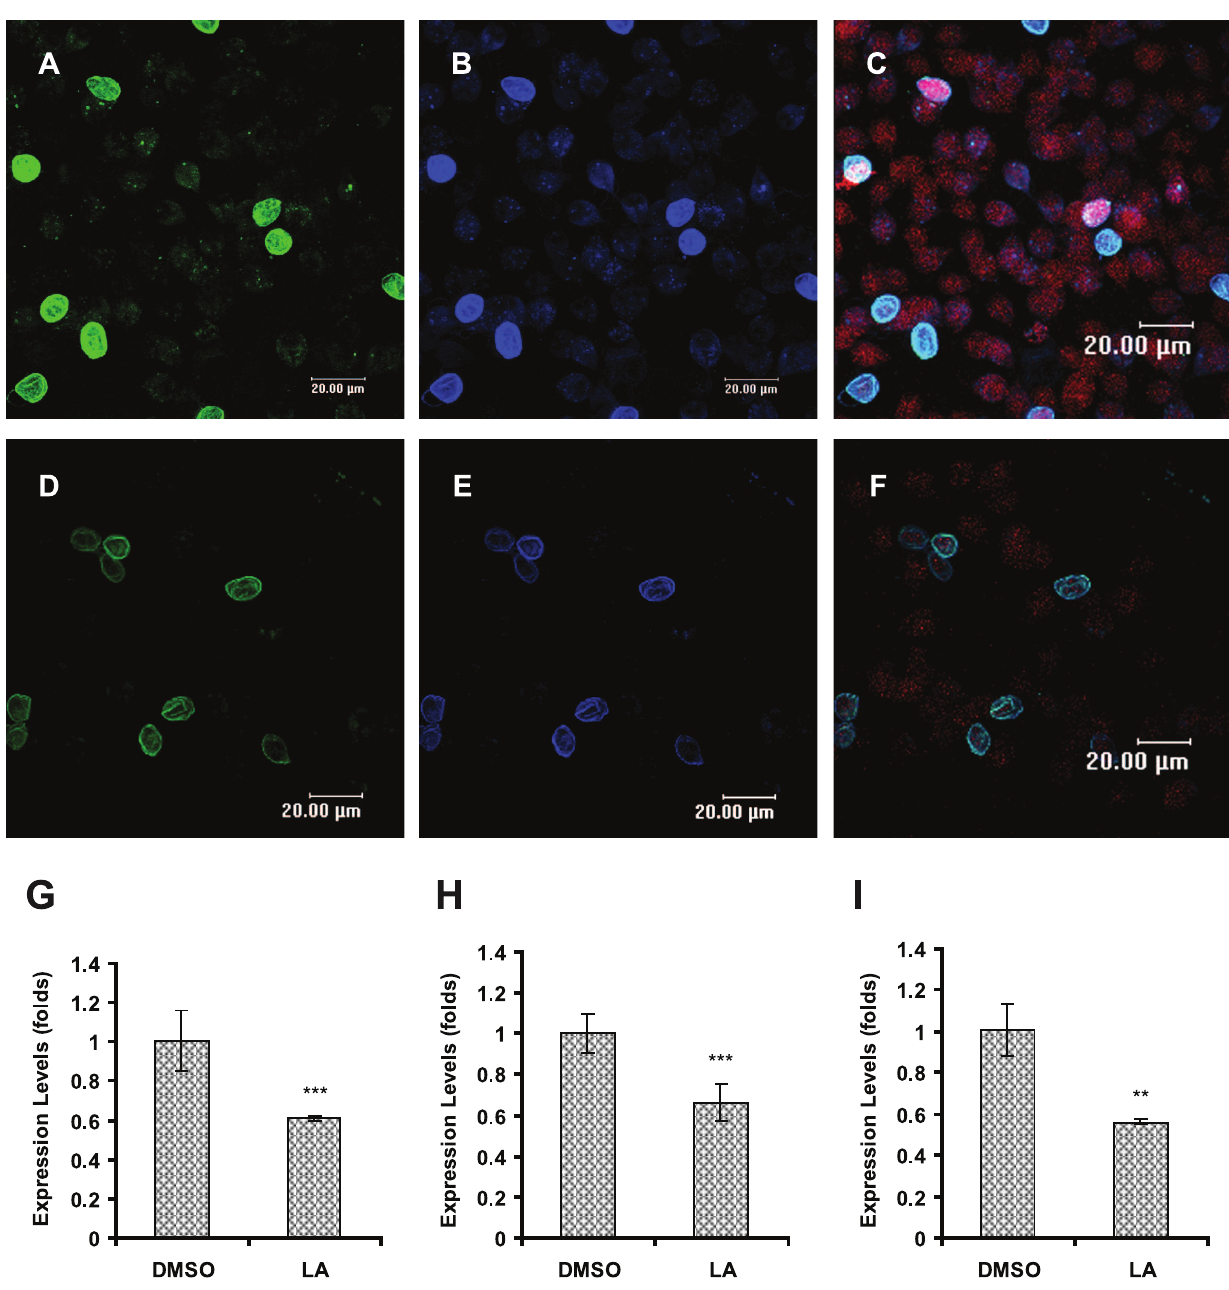
Figure 7. LA affects the staining of Rab11 and CWP1 and causes a down-regulation of their mRNAs during encystation. Cells induced to undergo encystation in the presence of 1 m M LA for 24 h ( D–F ) and cells induced to undergo encystation in the presence of 0.1% DMSO ( A–C ) were processed for confocal microscopy and stained with anti-Rab11 (green), anti-CWP1 (blue) and TRITC-phalloidin (red). Total RNA from these cultures was isolated and the expression of rab11 ( p =0.0033) ( G ), cwp1 ( p , 0.0001) ( H ) and actin ( p =0.0011) ( I ) was analyzed by relative-quantitative RT-PCR.